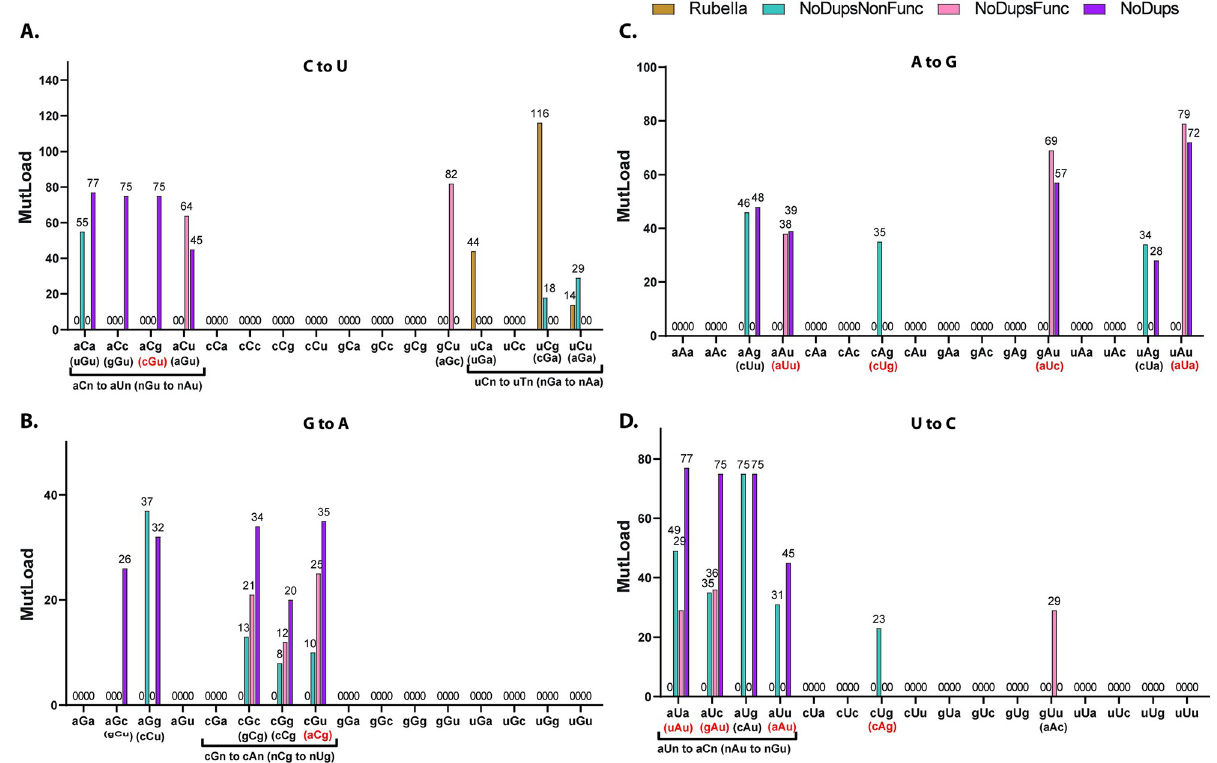
Fig 4. Trinucleotide-centered mutation motifs with statistically significant enrichment over random mutagenesis. Creation of filtered SARS-CoV- 2 MAFs and their abbreviated names NoDupsNonFunc, NoDupsFunc, NoDups are described in Fig 1 and in the associated text. The order of data in each group is the same as in the panel’s legend—Rubella, NoDupsNonFunc, NoDupsFunc, NoDups. Zero values are shown for the convenience of following the order of values within each group. Bars represent minimum estimates of mutation load that can be assigned to motif-specific mutagenic mechanism (MutLoad) as described in Methods. Statistical evaluation of enrichments was done by two-tailed Fisher’s exact test and corrected by FDR including p-values for all 192 possible trinucleotide-centered base substitution motifs. MutLoad for FDR > 0.05 = 0. Only results for motifs which included the most frequent base substitutions in the plus-strand, C to U, G to A, A to G, U to C, are shown. Reverse complement motifs in the plus- strand corresponding to the statistically significant motifs mutated in the minus-strand are shown in parentheses. If both plus-strand motifs in the reverse complement pair were statistically-significantly enriched in at least one dataset (in rubella or in a filtered SARS-CoV-2 MAF), they are highlighted in red font. Source data including calculations for all 192 motifs are in S6 Table.